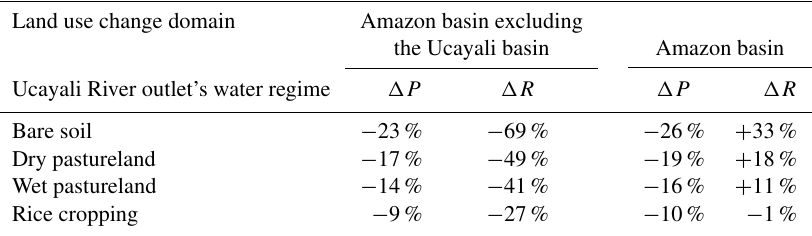
Table 6. Estimated changes in annual rainfall ( (cid:49)P ) and runoff ( (cid:49)R ) over the Ucayali River basin outlet following land use scenarios in the Amazon basin and the Amazon basin excluding the Ucayali